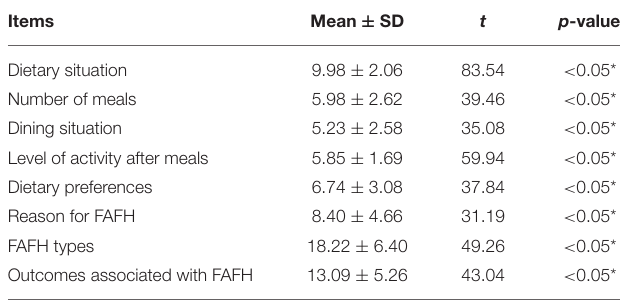
TABLE 1 | Participant demographics ( N = 300). TABLE 2 | FAFH consumption behavior scores of the participants ( N = 300).